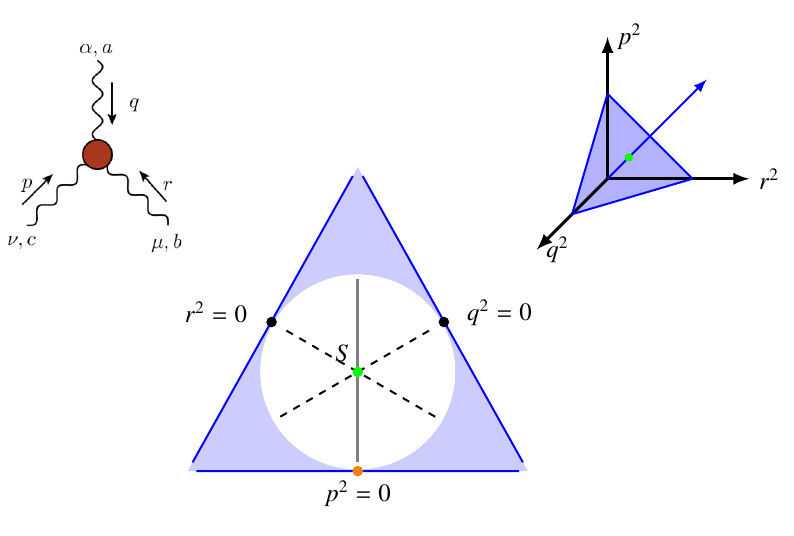
Figure 1. The kinematic configuration of the three-gluon vertex (left diagram) represented by the Cartesian coordinates ( q 2 , r 2 , p 2 ) (right picture). All kinematics allowed are contained in a circle around the symmetric case ( q 2 = r 2 = p 2 , green dot). The bisectoral line for r 2 = q 2 (thick gray), and the particular soft-gluon (orange solid circle), and symmetric (green) cases appear depicted. The other two bisectoral lines (black dashed) and their corresponding soft-gluon limits (black dots) are also